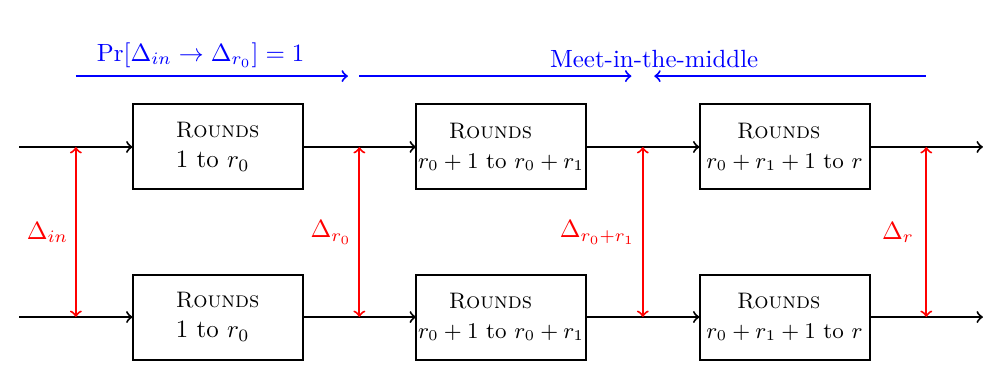
Figure 2: Overview of the